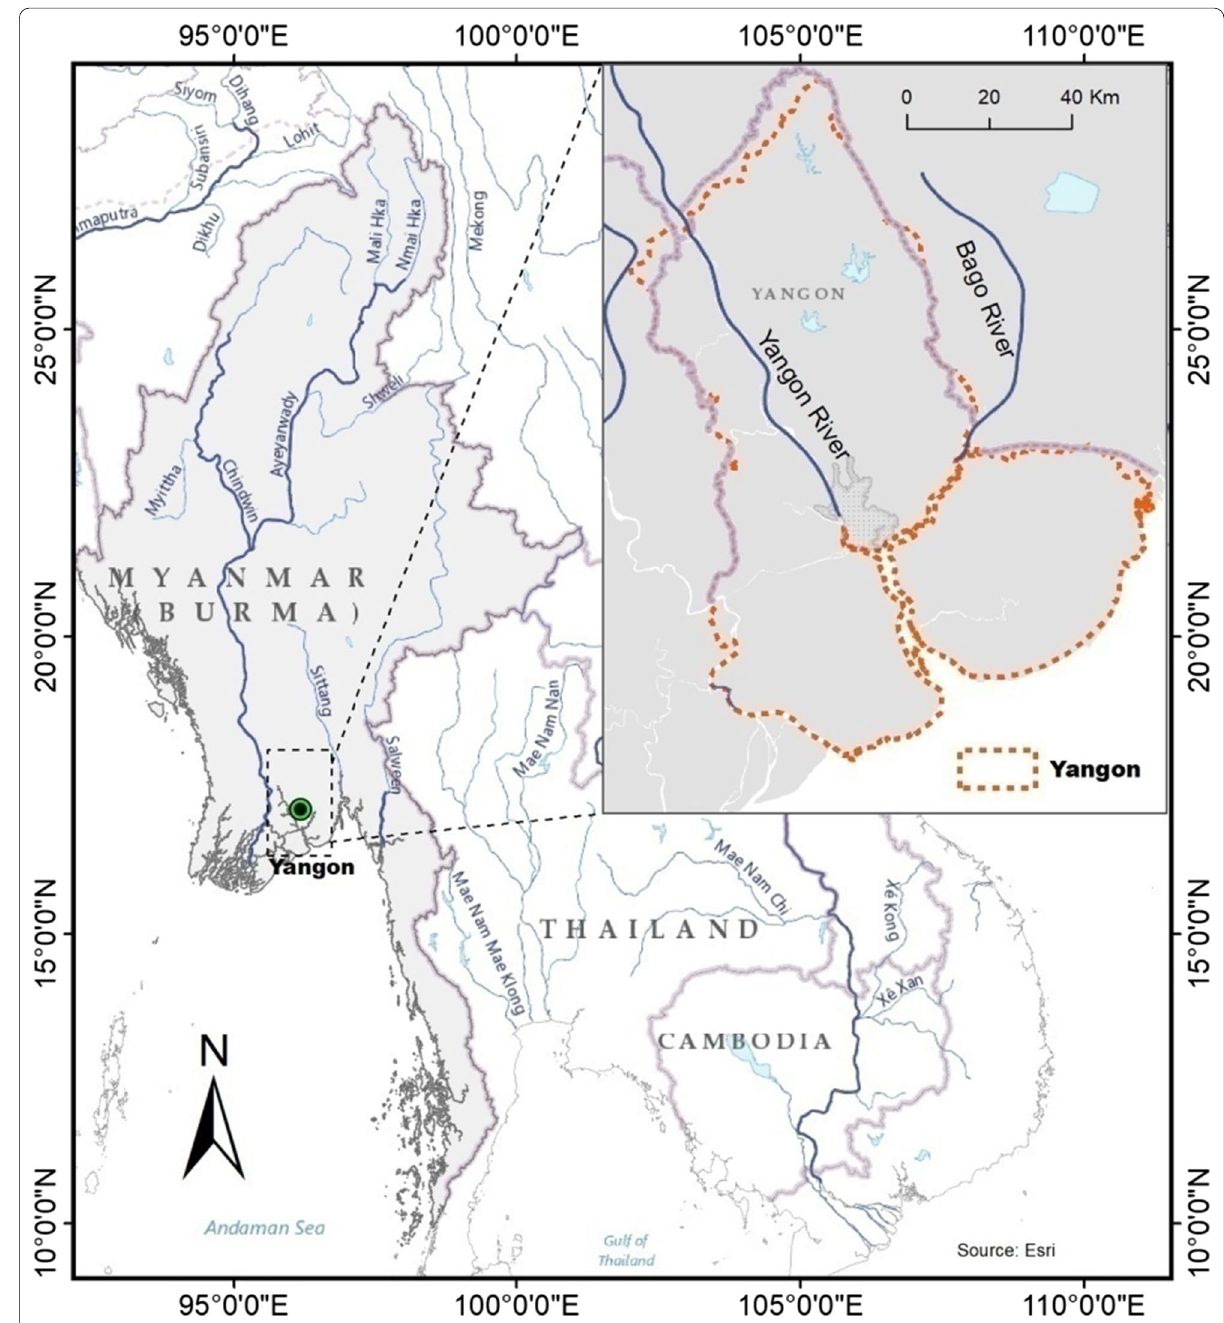
Fig. 1 Location of the Yangon Region in Myanmar in Southeast Asia. The red-dotted lines mark the boundaries of the Yangon Region that is equivalent to a province or a state in many countries. The city of Yangon is located at the confluence of the Bago and Yangon rivers (blue